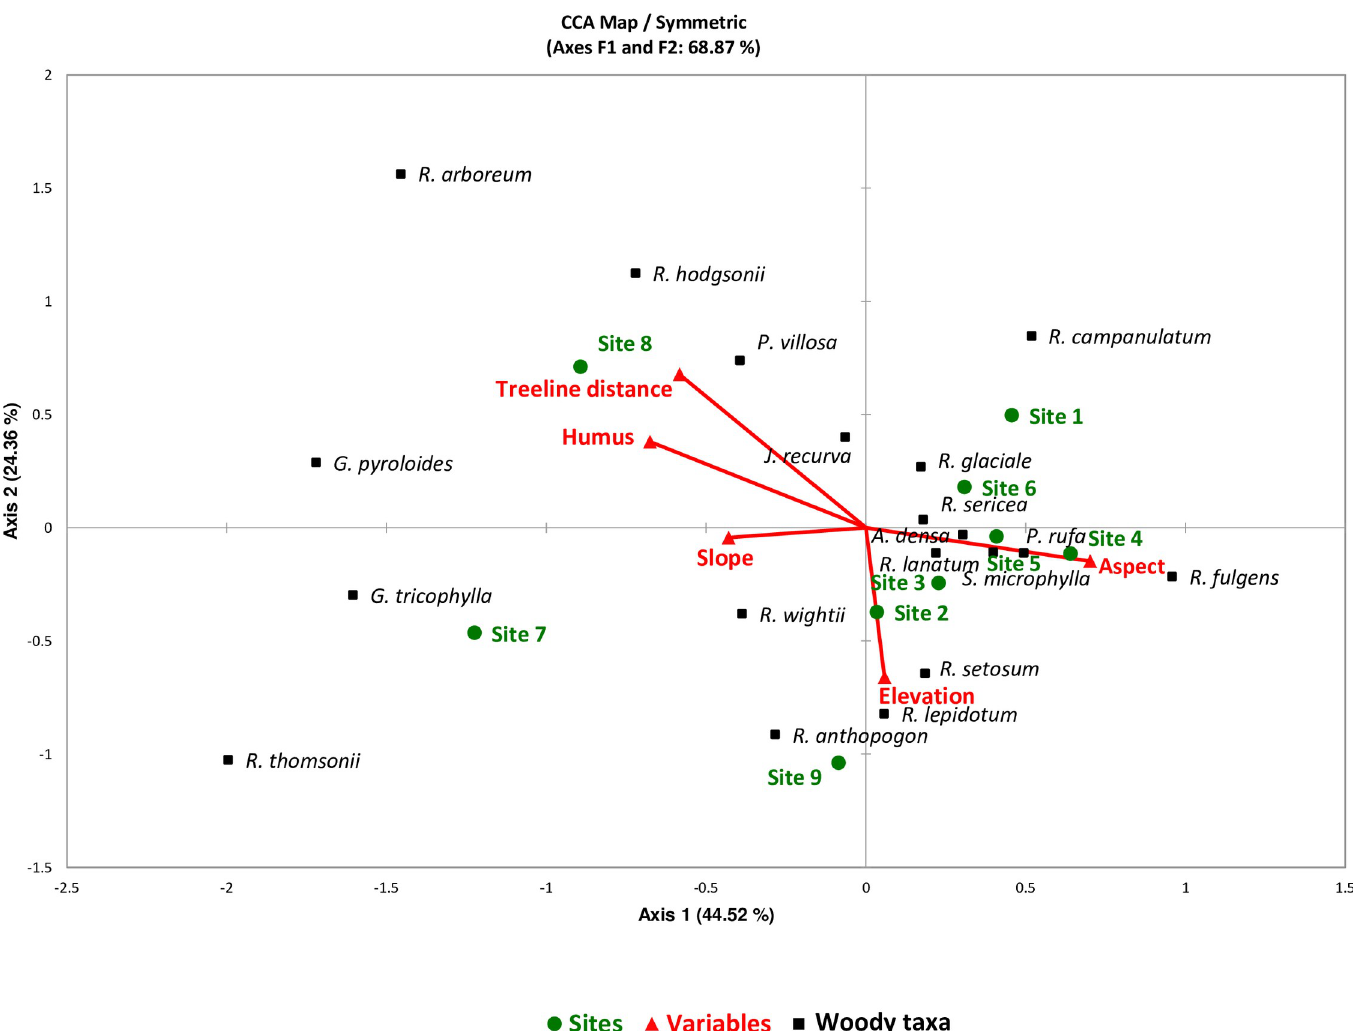
Fig 5. Canonical correspondence Analysis (CCA) triplot of timberline woody taxa, study sites and environmental variables in Khangchendzonga National Park.